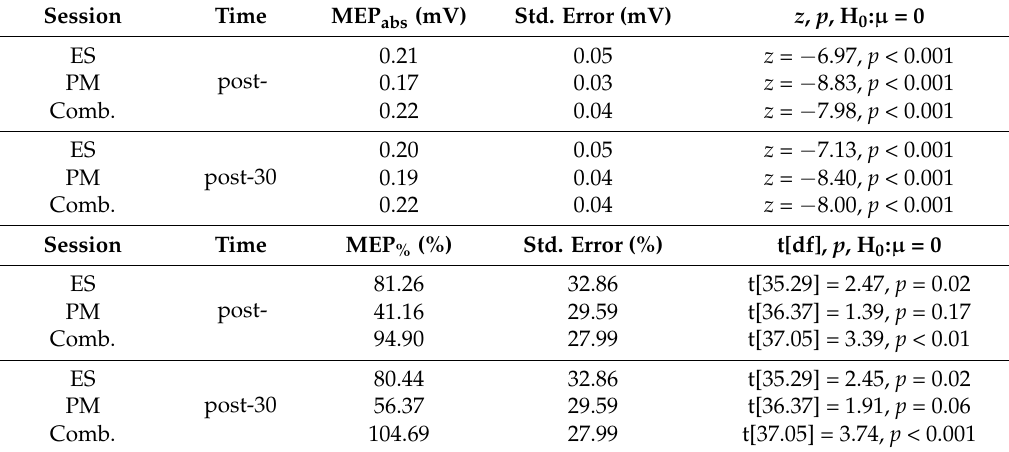
Table 3. Pre- to post- and post 30-effect sizes along with the standard errors estimated from the statistical models.